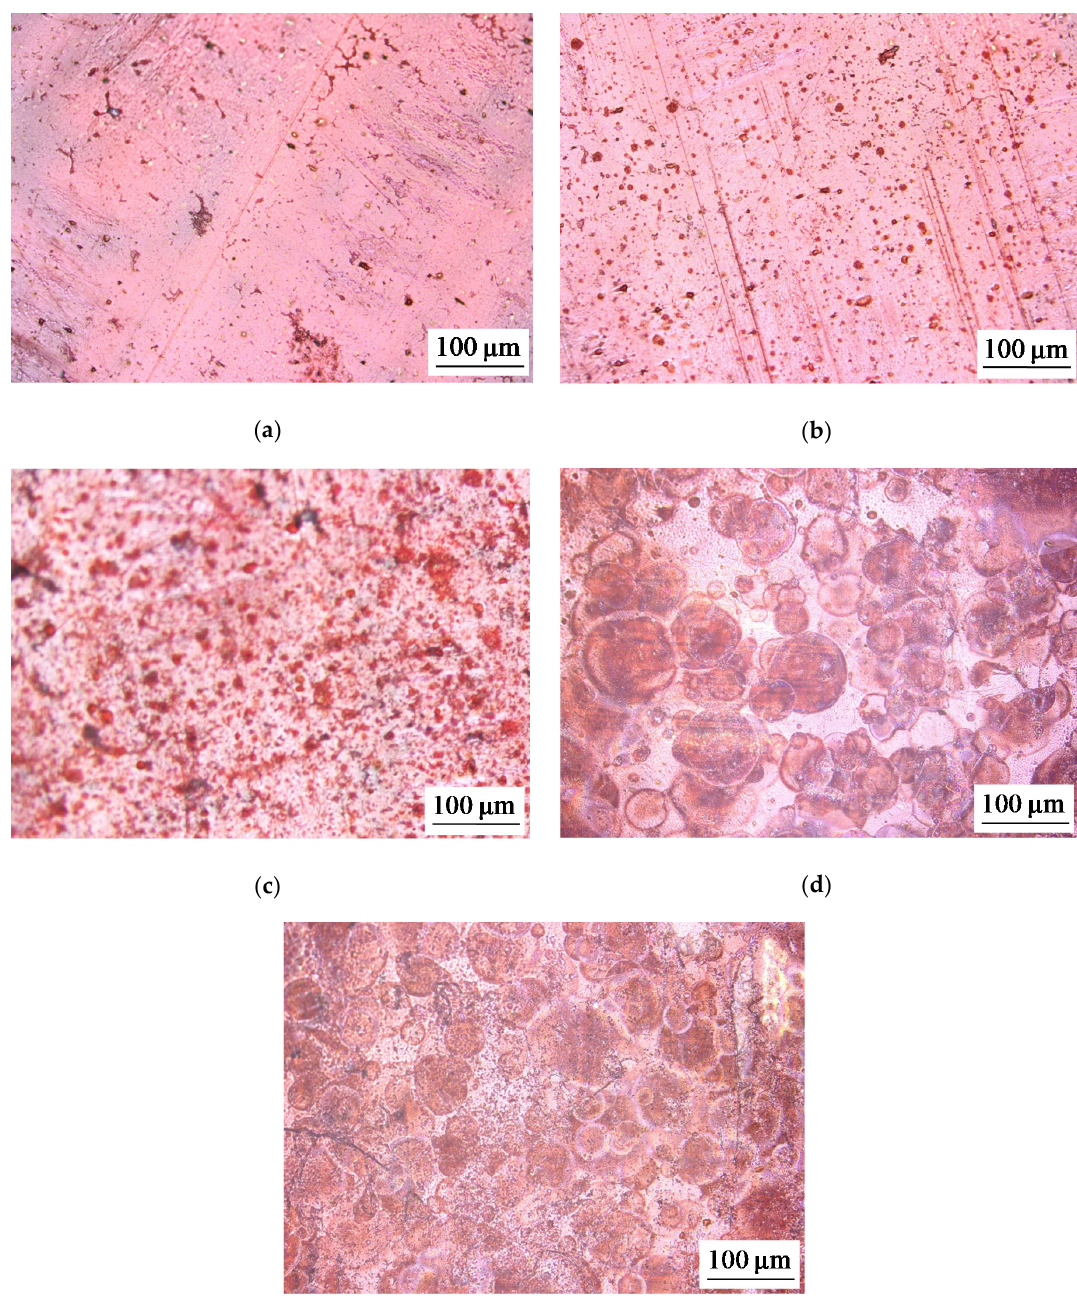
Figure 1. Optical images of the surface of swollen membrane samples: the pristine AMX-Sb membrane ( a ), and the modified AMX-Sb 1 ( b ), AMX-Sb 2 ( c ), and AMX-Sb 5 ( d ) membranes with relatively big spots of fluoropolymer material.